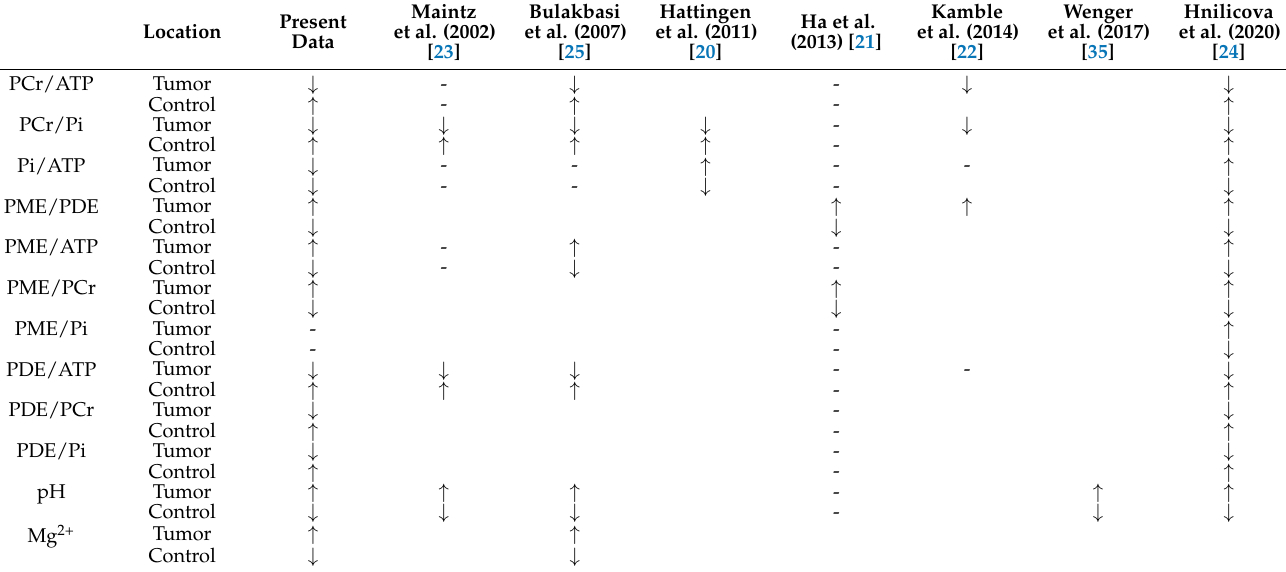
Table 2. Comparison of the present data with data from the literature. The region with higher values is marked with “ ↑ ” and the region with lower values with “ ↓ ”. If no differences between the regions were found, it was marked with “-”.